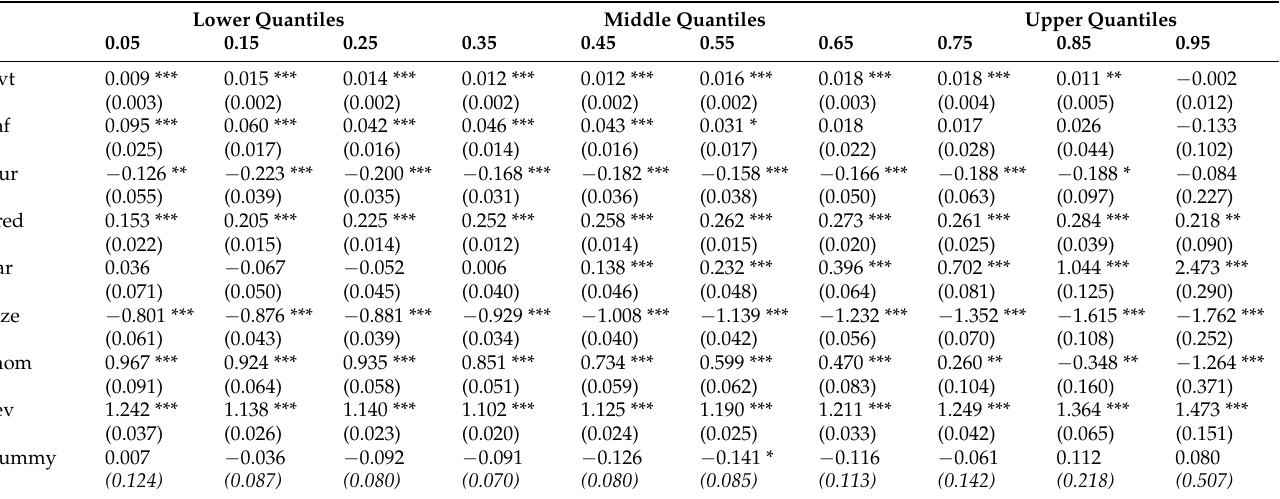
Table 6. Panel Conditional Quantile Regression—Robustness Analysis Using a Different Set of Control